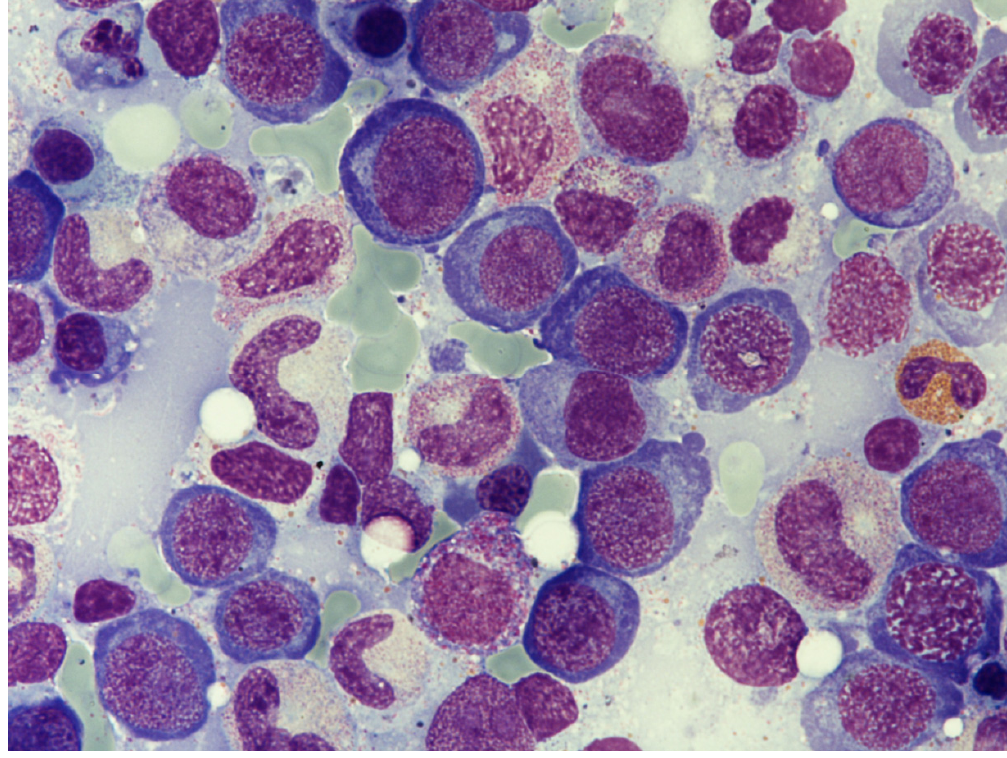
Figure 1. Bone marrow aspiration; May-Grunwald-Giemsa staining; magnification (600×) shows a hypercellular marrow with a reduced myeloid-to-erythroid ratio of about 1:1 (normal 3:1). Megaloblastic basophilic and polychromatophilic erythroblast are prominent, with their reticular and finely dense chromatin. Progenitor myeloid cells also display large dimensions and fine chromatin. Cytoplasmic granulation occurs